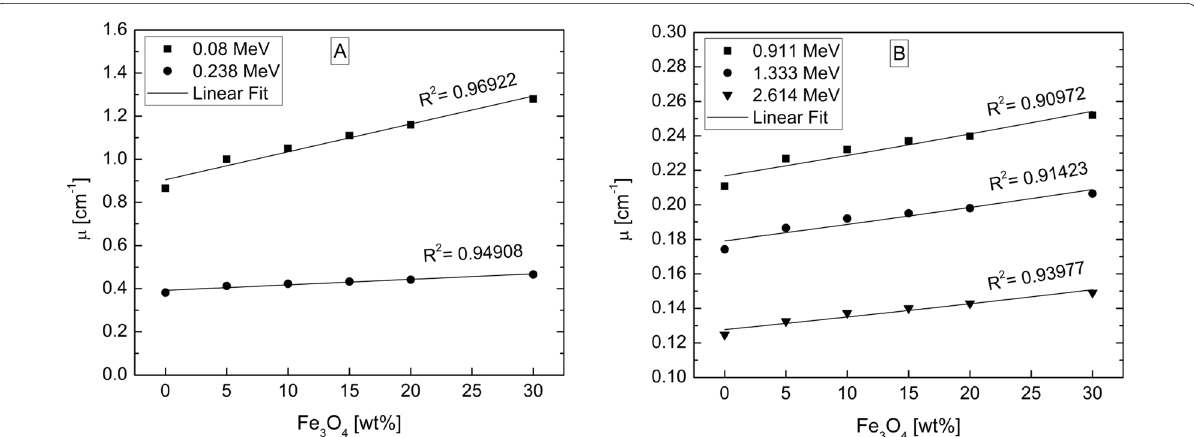
Fig. 13 The linear attenuation coefficient of Fe 3 O 4 nanoparticle cement paste, as a function of the weight percentage of Fe 3 O 4 , for two dominant regions: a the photoelectric absorption and b Compton scattering interaction